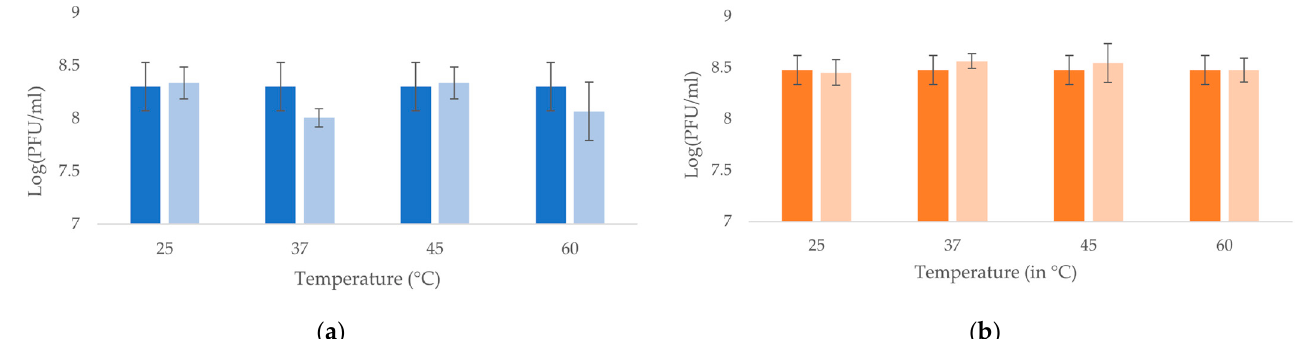
Figure 4. Temperature stability of the bacteriophages ( a ) vB_KpnP_K3-ULINTkp1 and ( b ) vB_KpnP_K3-ULINTkp2 after 1 h at the desired temperature (in °C). The means of 3 titrations (± σ ) are represented, and the concentrations measured before testing are represented with dark bars.